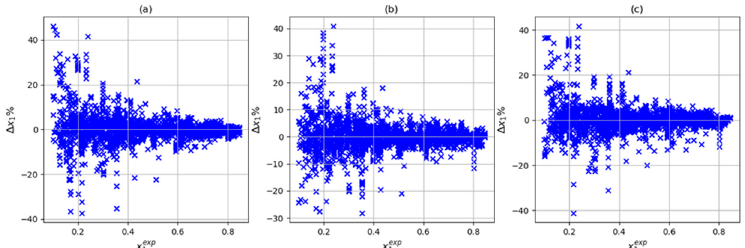
Figure 8. Dispersion of training in three input combination studies with (4,6,8,1) architecture: ( a ) T, P, Tc, and Pc, ( b ) T, P, Tc, Pc, and ω , and ( c ) T, P, Tc, Pc, and Zc. Table 6. Weights and bias of the optimized ANN architecture for the input to the first hidden layer.